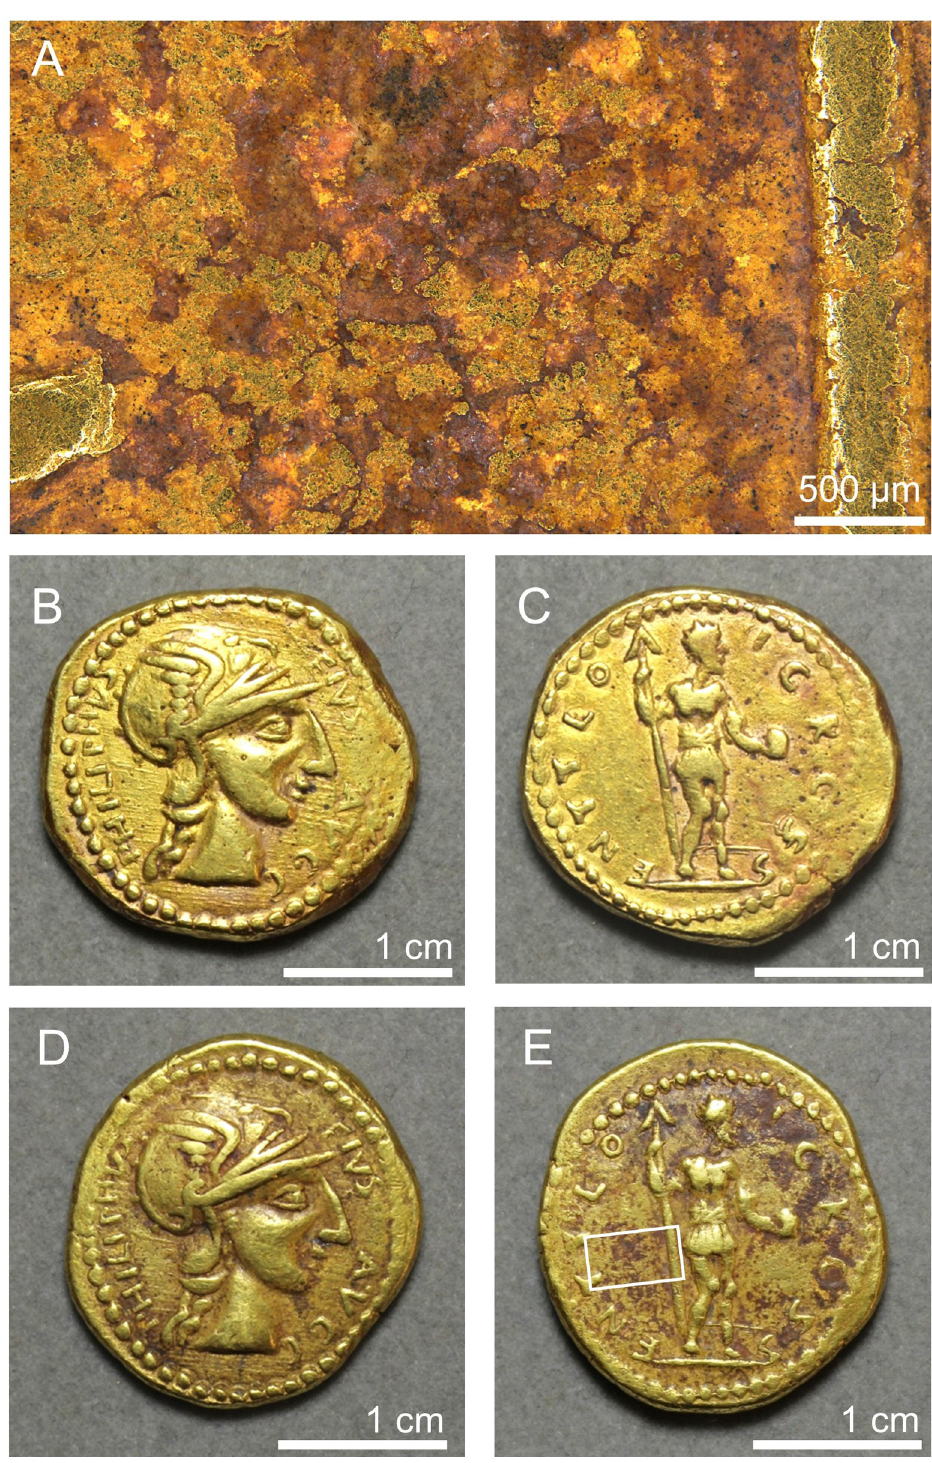
Fig 5. Evidence for casting. A, D, E, GLAHM:29821 (the box on E is the area shown in A); B, C, Coin GLAHM:29820 (same as Fig 2).